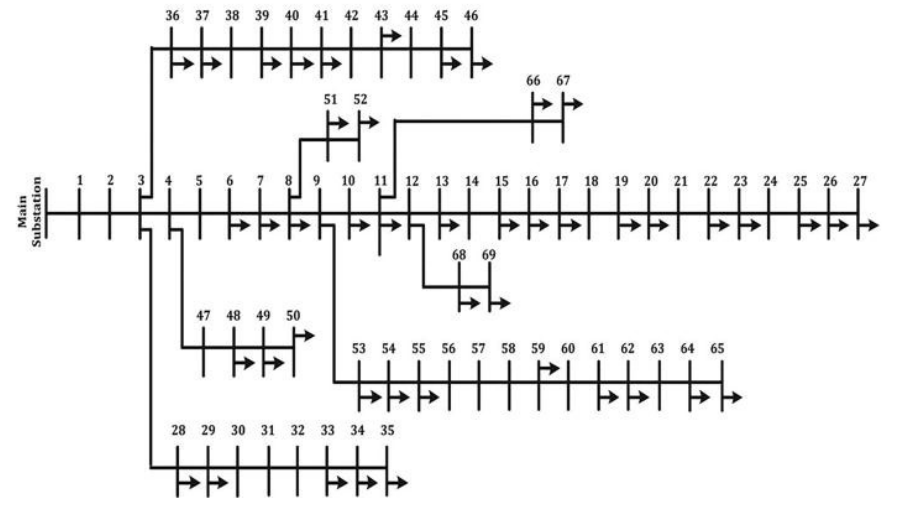
Figure 6. Topology of the IEEE-69 system.